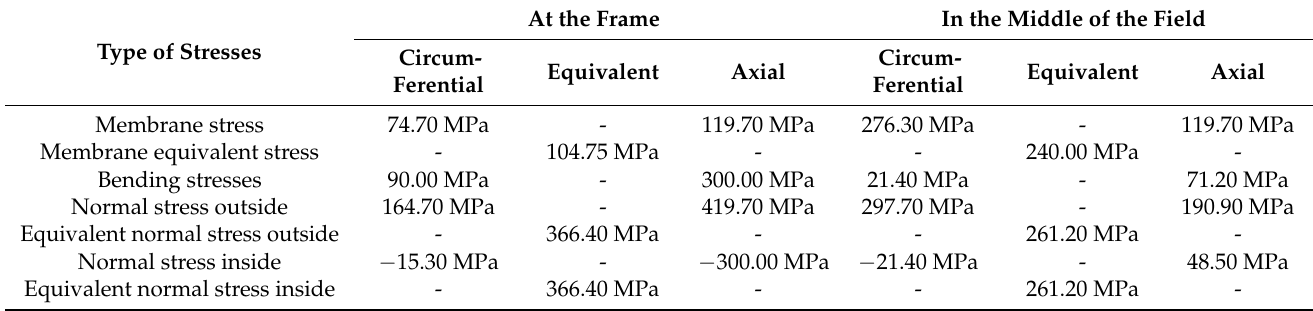
Table A5. Stresses in the flooded compartment (collapse diving depth) for SST 1: Subsea shuttle tanker (Cargo 10,569 m 3 ).